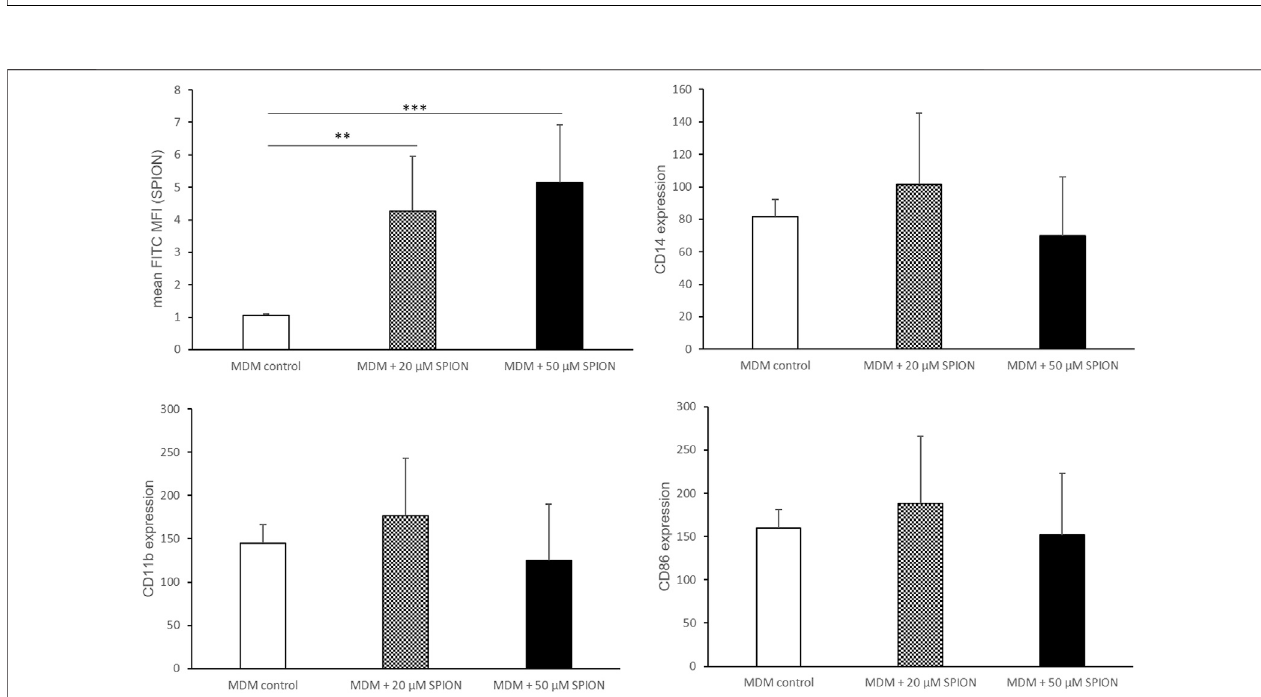
FIGURE3| PhenotypeofSPIONincubatedTHP-1cellswithandwithoutadditionalPMAtreatmentformacrophagedifferentiation.Cellswereeitherincubatedwith SPIONs alone or in combination with PMA to induce macrophage differentiation. SPION incubation was performed over 24 h. Cells without SPIONs served as control. FITC expression of cells represents SPION uptake. Shown are the mean fl uorescence intensities (MFI) of each measured protein on the cell surface. Signi fi cance: student`s t -Test. * p ≤ 0.05; **** p ≤ 0.0001. n = 6.